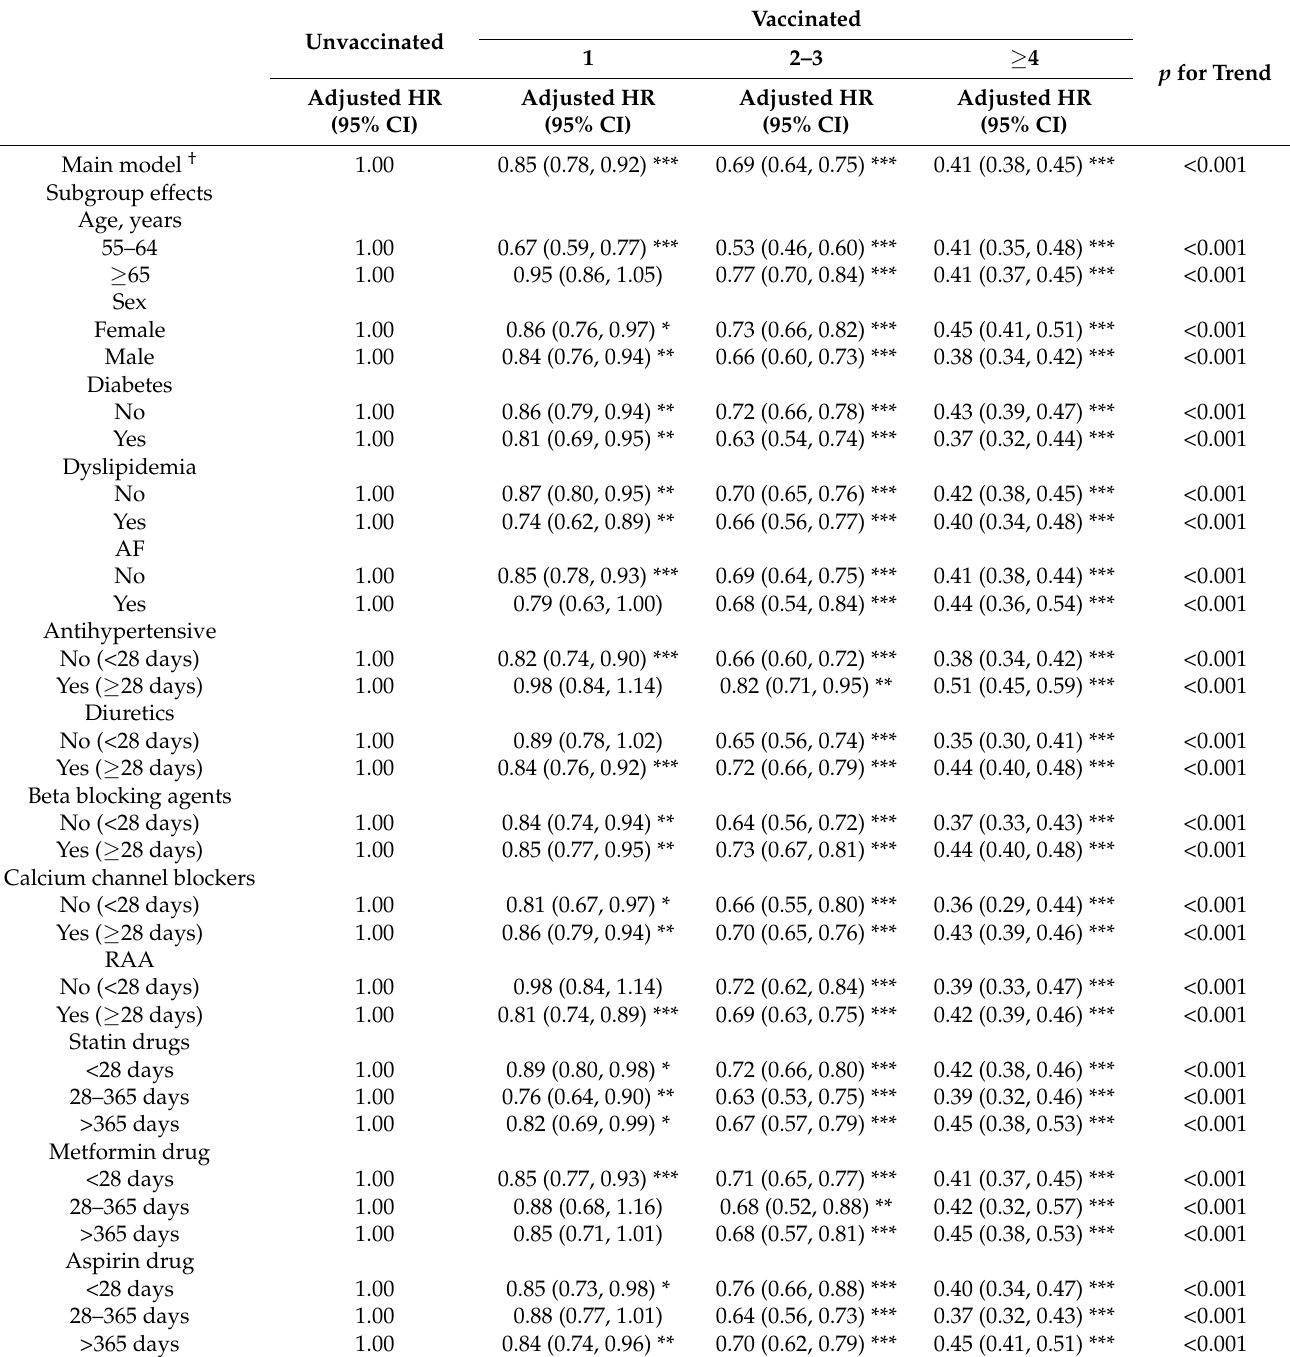
Table 3. Sensitivity Analysis of Adjusted HRs of Vaccination in the Risk Reduction of All Strokes in the Influenza Season. Vaccinated Unvaccinated Trend1 2–3 ≥